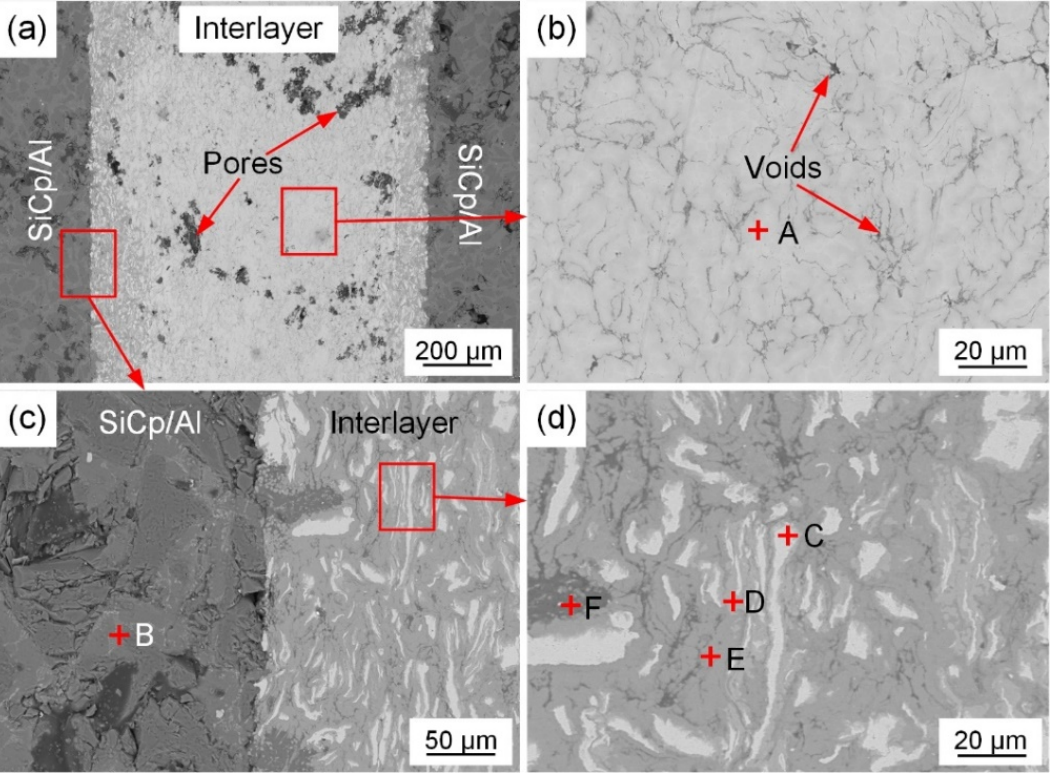
Figure 7. Microstructure of the joint bonded with Al/Ni interlayer (4 MPa). ( a ) Overall joint; ( b ) joint center; ( c ) bonding interface; ( d ) enlargement of zone in ( c ).